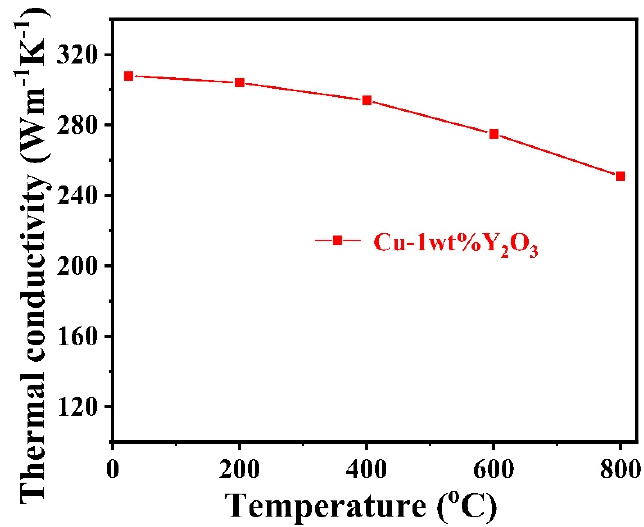
Figure 9. Thermal conductivity of Cu-1wt%Y 2 O 3 alloy at different temperatures.